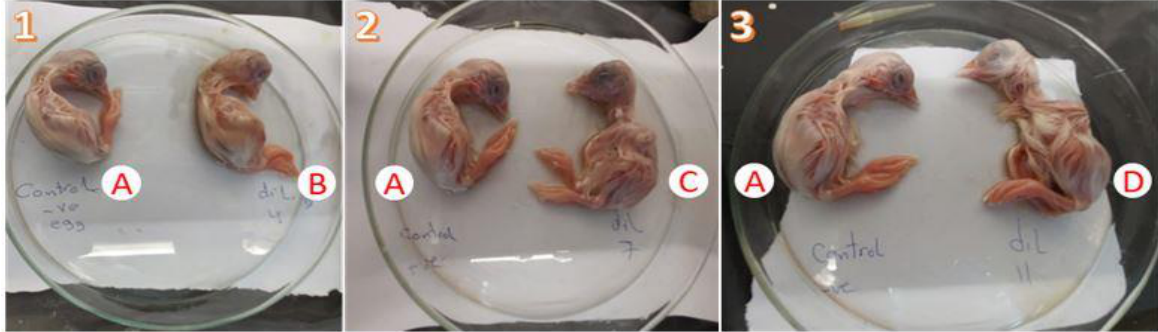
Fig. 1: Effect of different dilutions for example , B: (dilution no 4), C: (dilution no 7) and D:(dilution no 11) of mixture of ECV extract and NDv on inoculated embryos that loss viral titer and infectivity A: control negative.